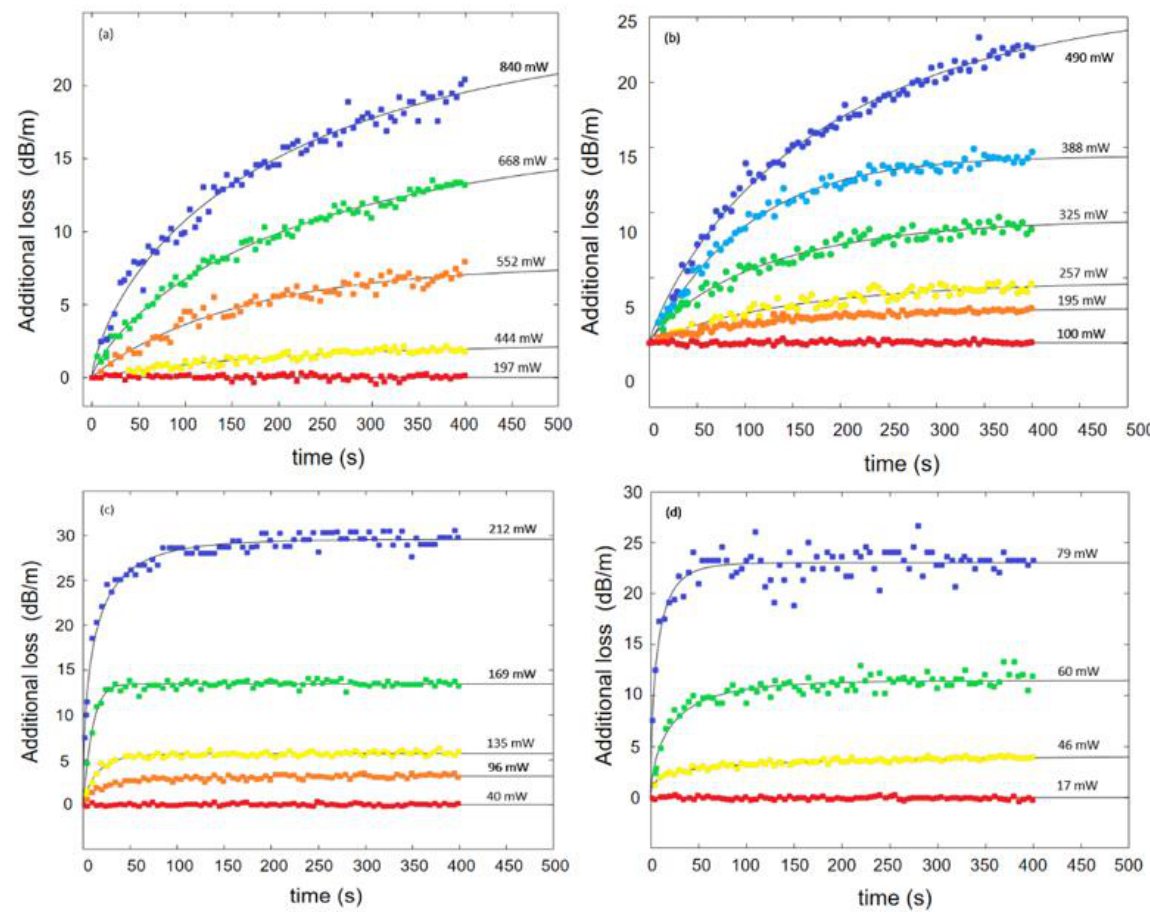
Figure 6. Measurement and fitting results of ( a ) Fiber A, ( b ) Fiber B, ( c ) Fiber C and ( d ) Fiber D.